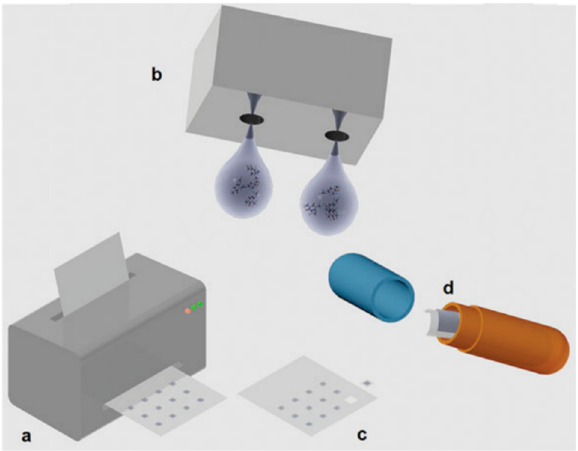
Figure 11. Schematic demonstration of the printing concept for pharmaceutical oral dosage form: ( a ) inkjet printer, ( b ) therapeutic material deposition, ( c ) unit doses on a paper substrate and ( d ) doses inserted to be into capsules or directly fabricated into oral dosage forms. [61].